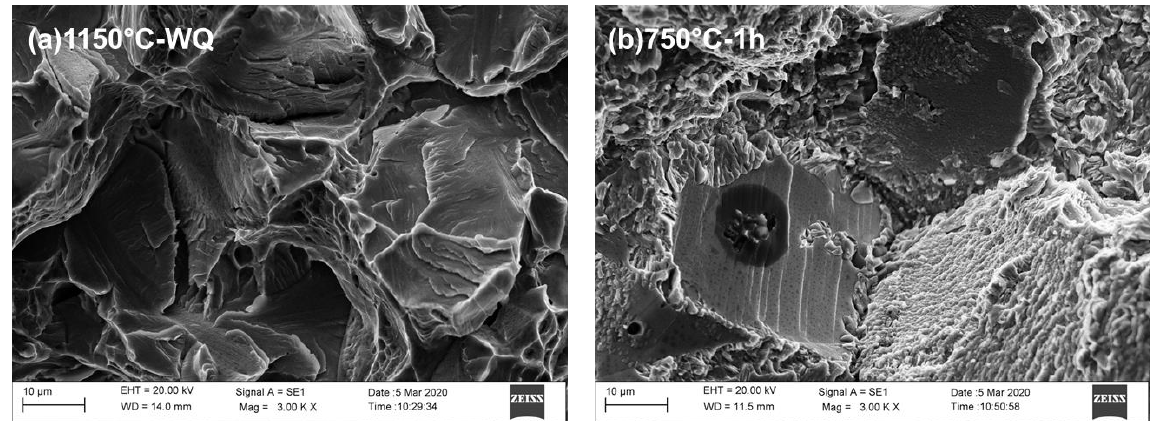
Figure 11. Fractography images obtained after mechanical tests of the samples that were ( a ) water-quenched from 1150 °C and ( b ) treated at 750 °C for one hour.